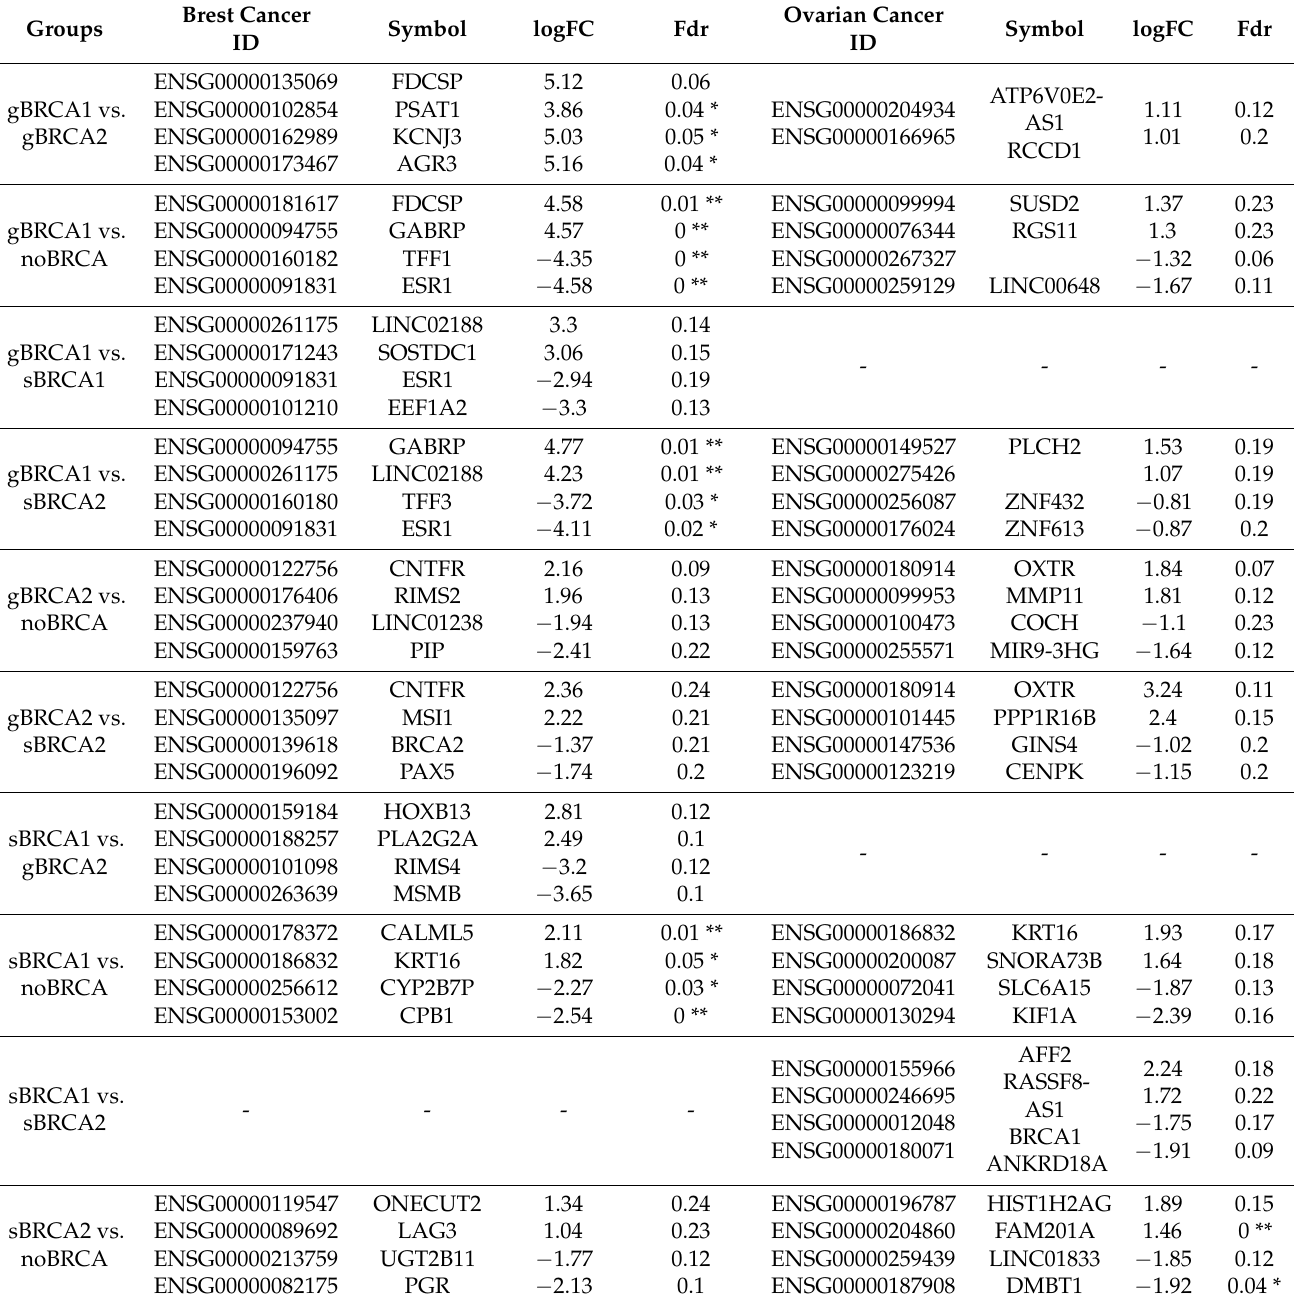
Table 2. Groupwise analysis of differential expression analysis in breast and ovarian cancers. Groups